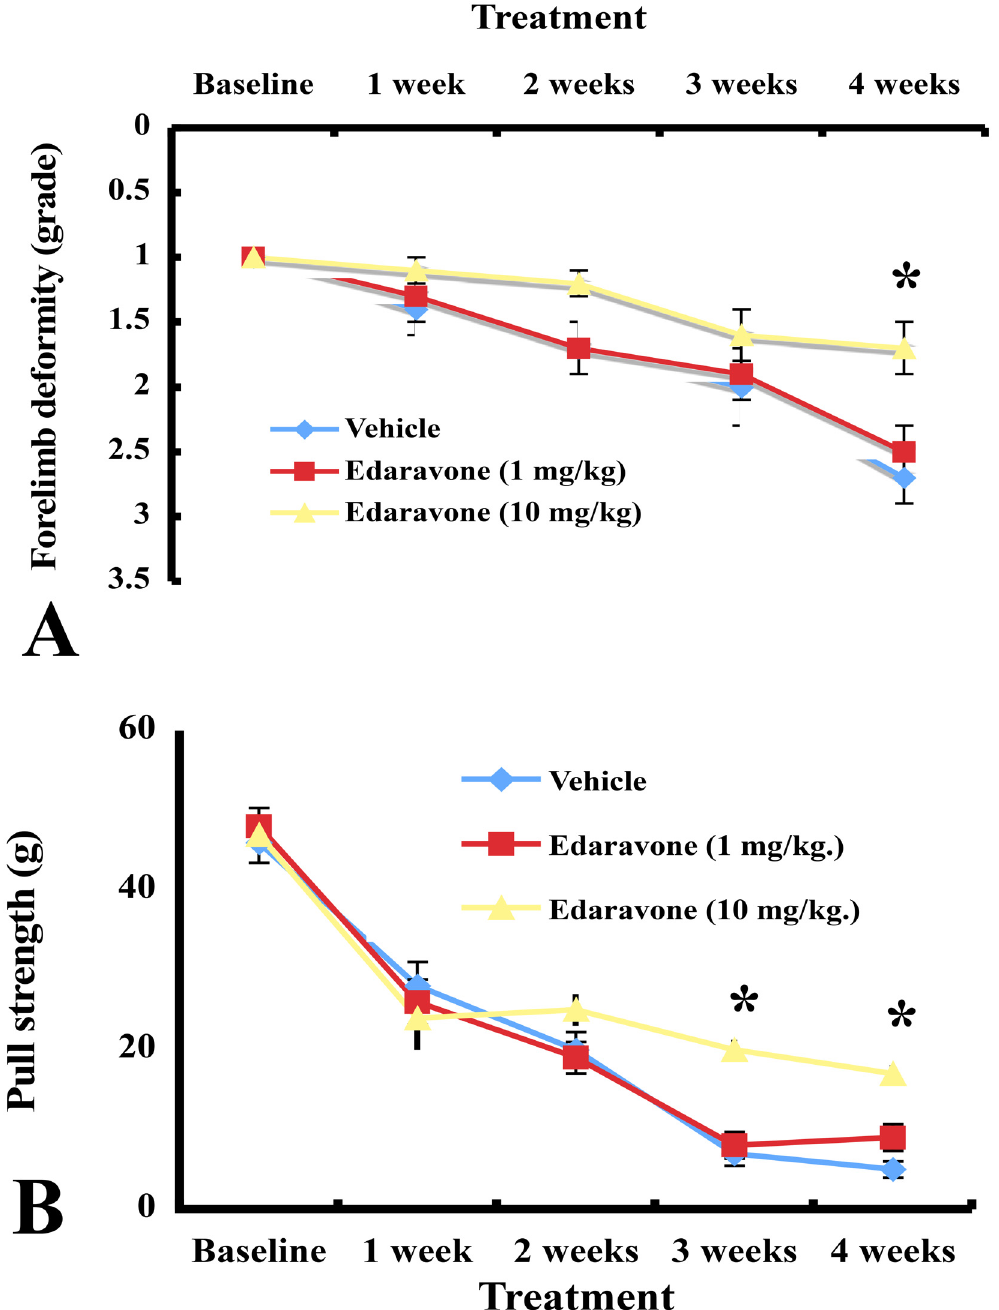
Fig 1. Forelimb deformity and pull strength changes after treatment with edaravone and vehicle. (A) The forelimb deformity was attenuated in mice treated with higher dose of edaravone. * P < 0.05, the higher dose of edaravone group versus the vehicle group at the 4th week (one-way repeated measures ANOVA followed by Dunnett type multiple comparison test). Results are represented as the mean ± SEM (n = 10/group). (B) Vehicle-treated mice decreased forelimb strength gradually. Higher dose of edaravone administration inhibited deterioration of forelimbs strength. * P < 0.05, the higher dose of edaravone group versus the vehicle group at the 3rd and the 4th week (one-way repeated measures ANOVA followed by Dunnett type multiple comparison test). Results are represented as the mean ± SEM (n = 10/group).